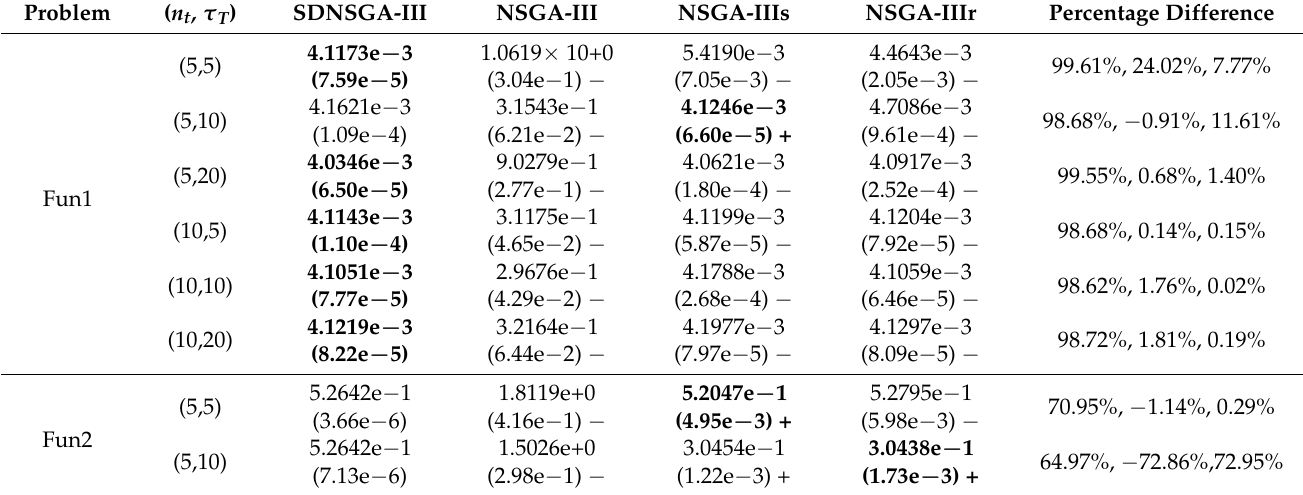
Table A2. The MIGD values and standard deviations obtained by four